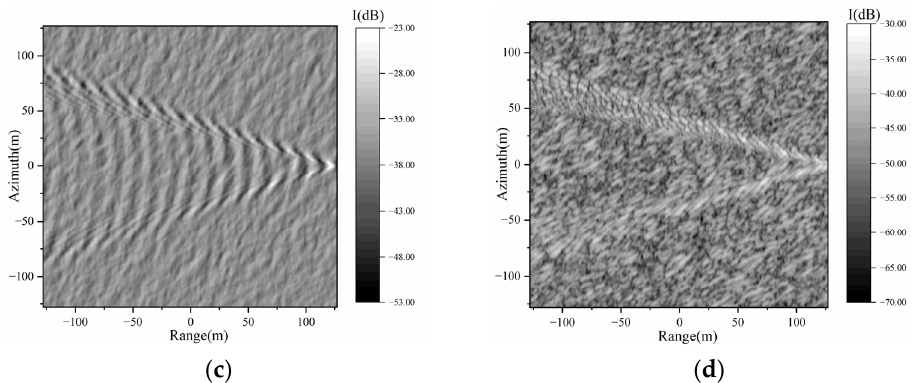
Figure 7. Simulated SAR image of ship wake in different polarization conditions. ( a ) wake model; ( b ) VV polarization; ( c ) HH polarization; ( d ) VH polarization.